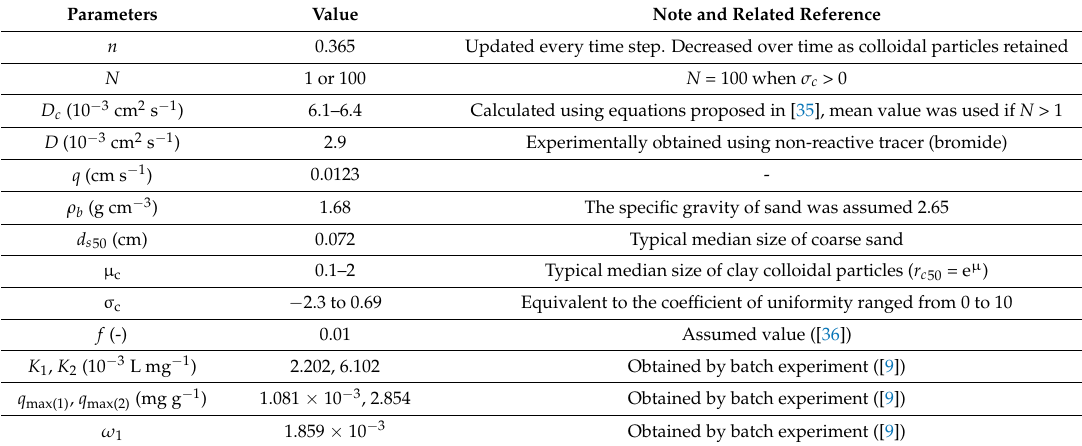
Table 1. Parameters adopted in numerical